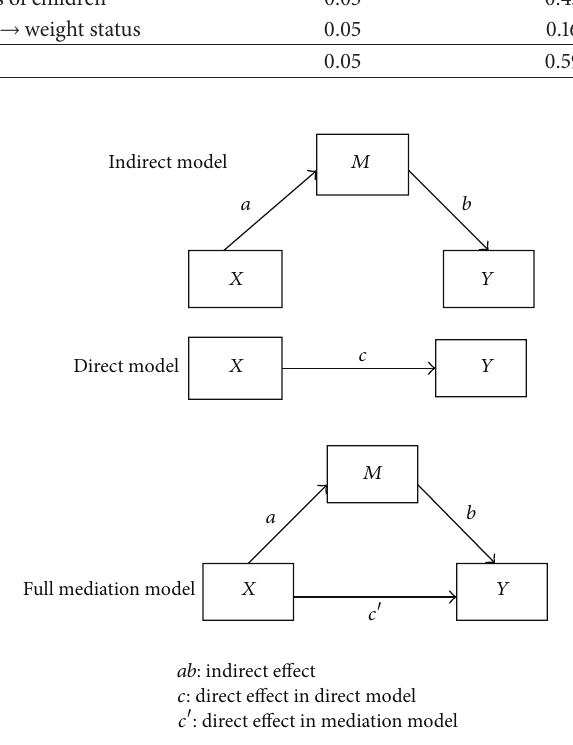
Figure 13: Indirect, direct, and full mediation model [27].